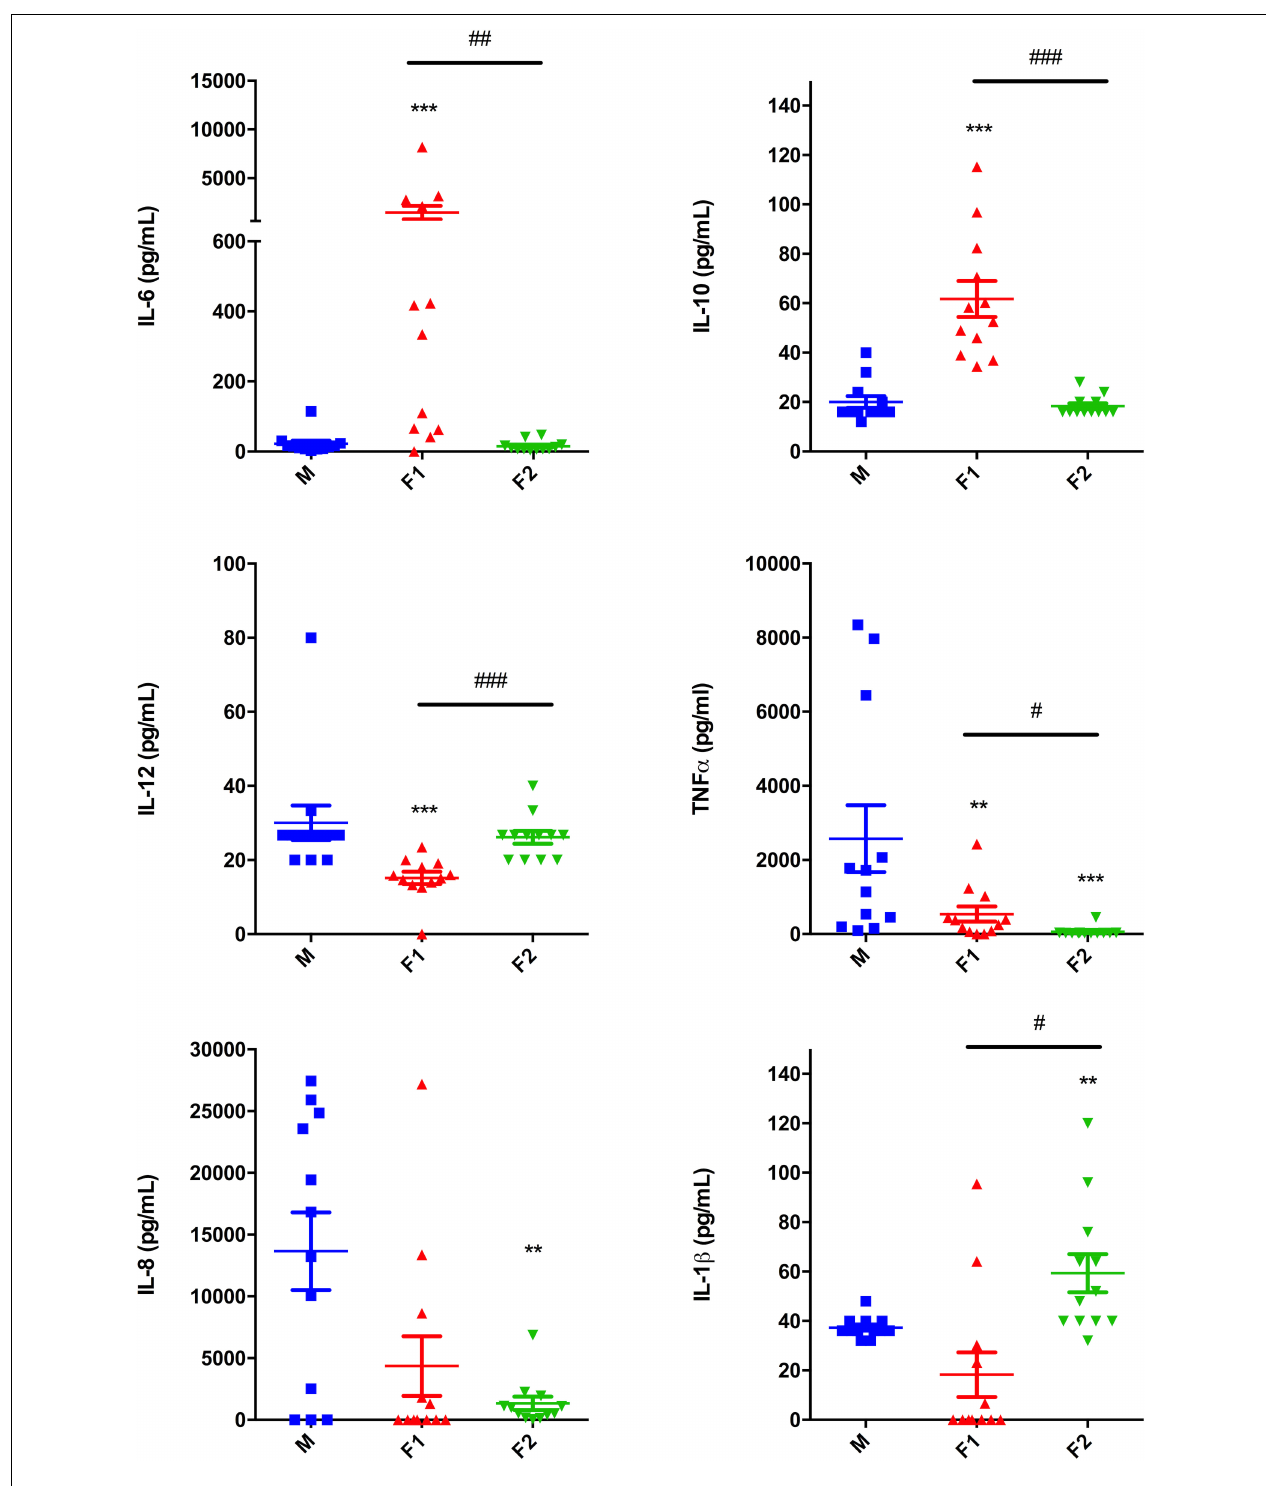
FIGURE 4 | Paracoccidioides brasiliensis cell wall fractions modulate cytokine production by dendritic cells. IL-6, IL-10, IL-12, TNF, IL-8, and IL-1 β levels were measured in the cell culture supernatants after differentiation upon F1 or F2 stimulation. Non-stimulated cells were used as a control (M). Each data point represents one donor. Wilcoxon matched pairs T test. ∗∗ p < 0.01 and ∗∗∗ p < 0.001 in comparison to control group. # p < 0.05, ## p < 0.01, and ### p < 0.001 between groups treated with cell wall fractions.